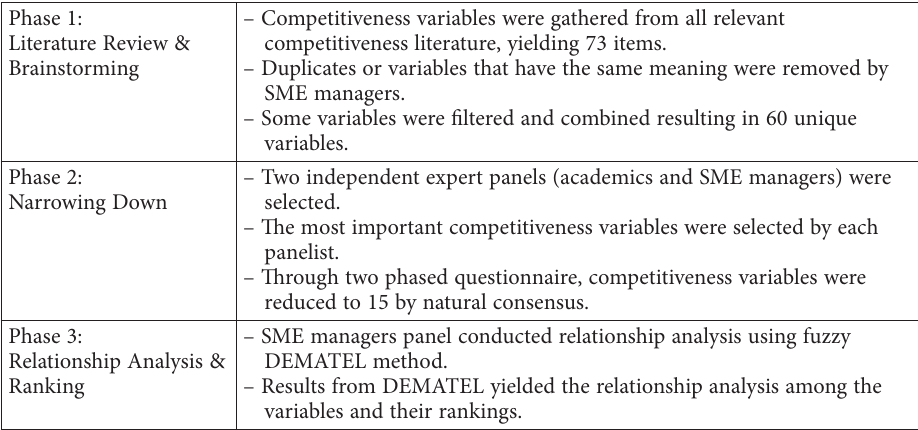
Table 4. Empirical application of the Proposed hybrid model Phase 1: Literature Review